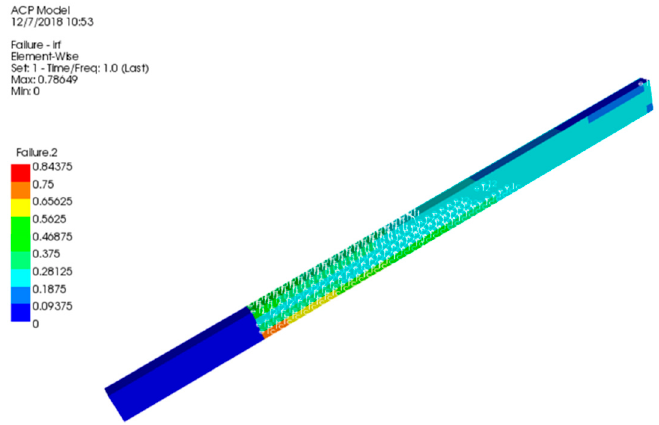
Figure 13. Maximum strain failure criterion for the composite beam with a load of 343.35 N.